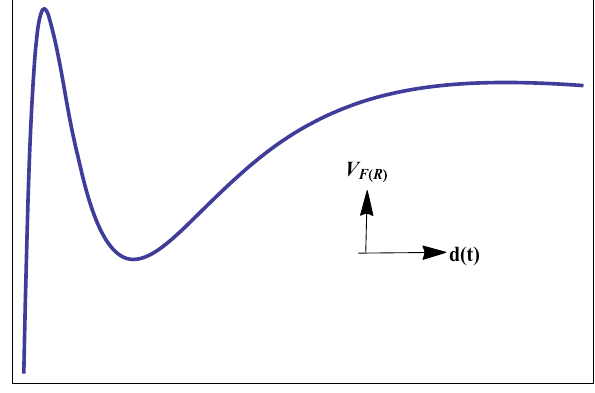
√ 2 , k = M = 1 ,(cid:11) = 3